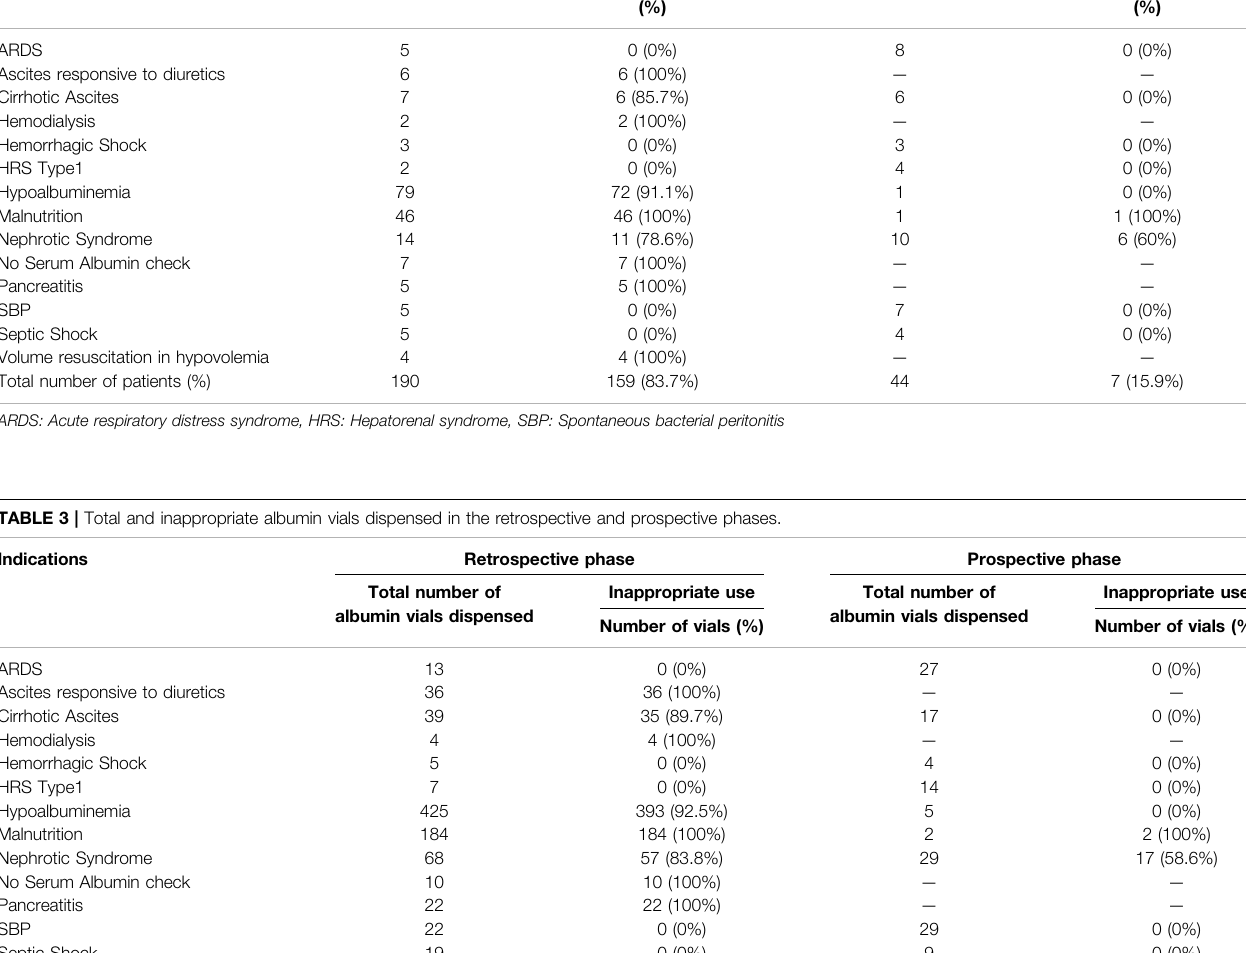
TABLE 2 | Inappropriate human albumin indications in the retrospective and the prospective phases. Indications Retrospective phase